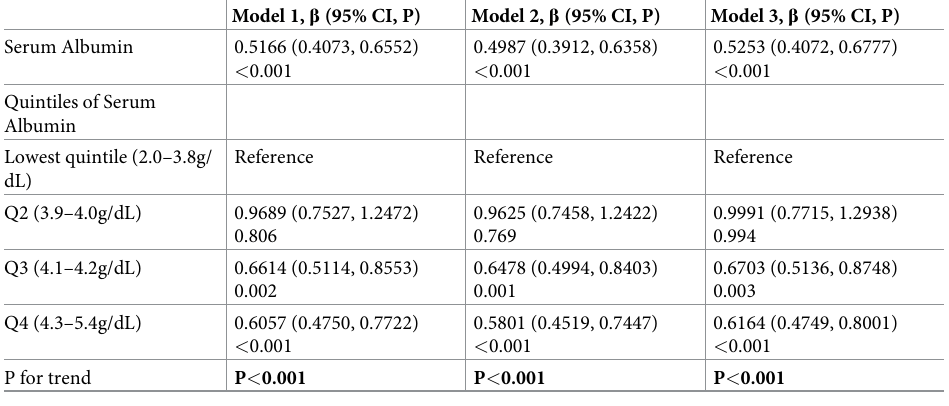
Table 2. Association between serum albumin (g/dl) and diabetic retinopathy